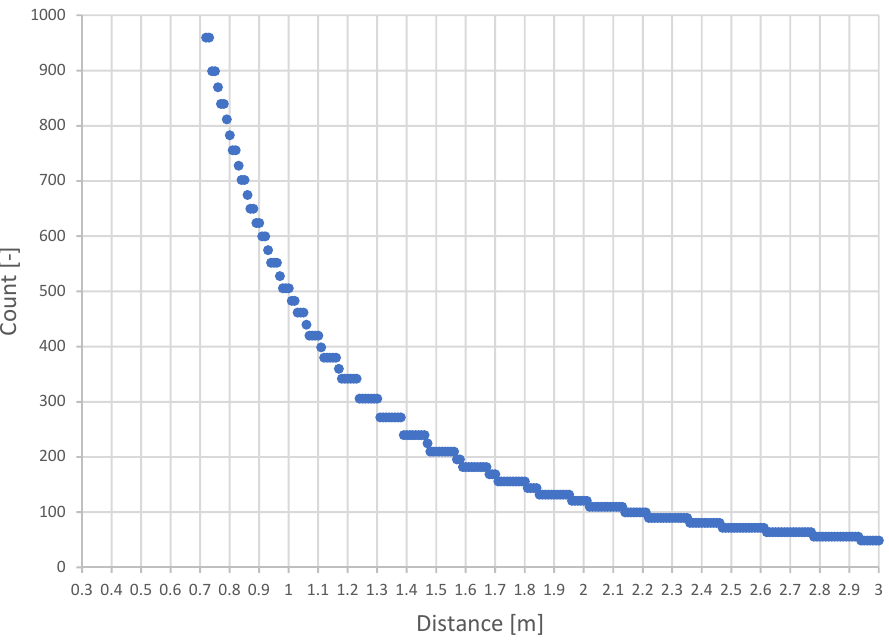
Figure 9. Density of expected points of a voxel depending on the distance from the camera. A simplified calculation of the maximum voxel capacity is described in Algorithm 6.